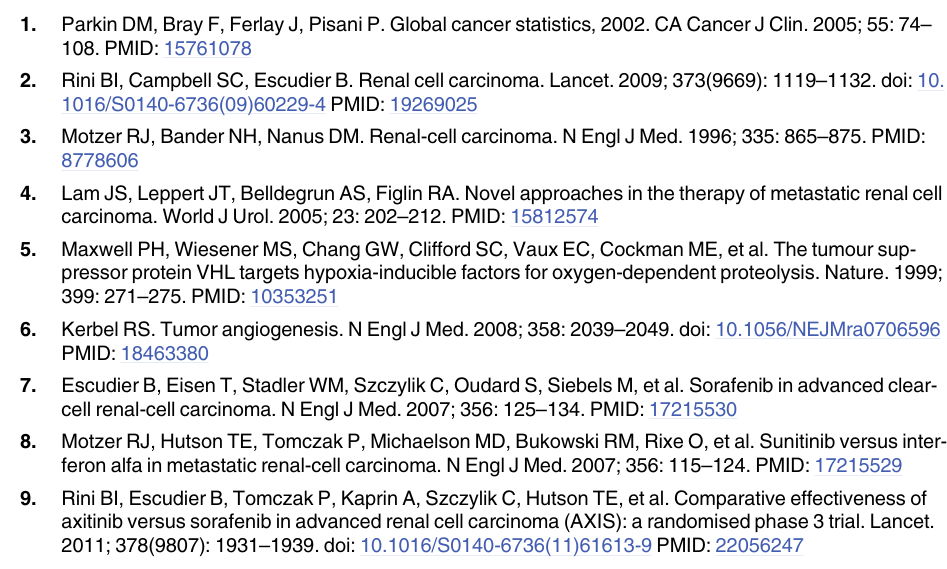
S1 Fig. Comparison of the knocking down efficiency among the control siRNA and two independent si-hnRNP K (s6738 and s6739) in A498 cells. (TIF) S2 Fig. A. Immunoreactivity of hnRNP K in normal renal proximal tubules B. Comparison of hnRNP K staining score between normal renal tissue and Fuhrman grade 1 RCC specimens.